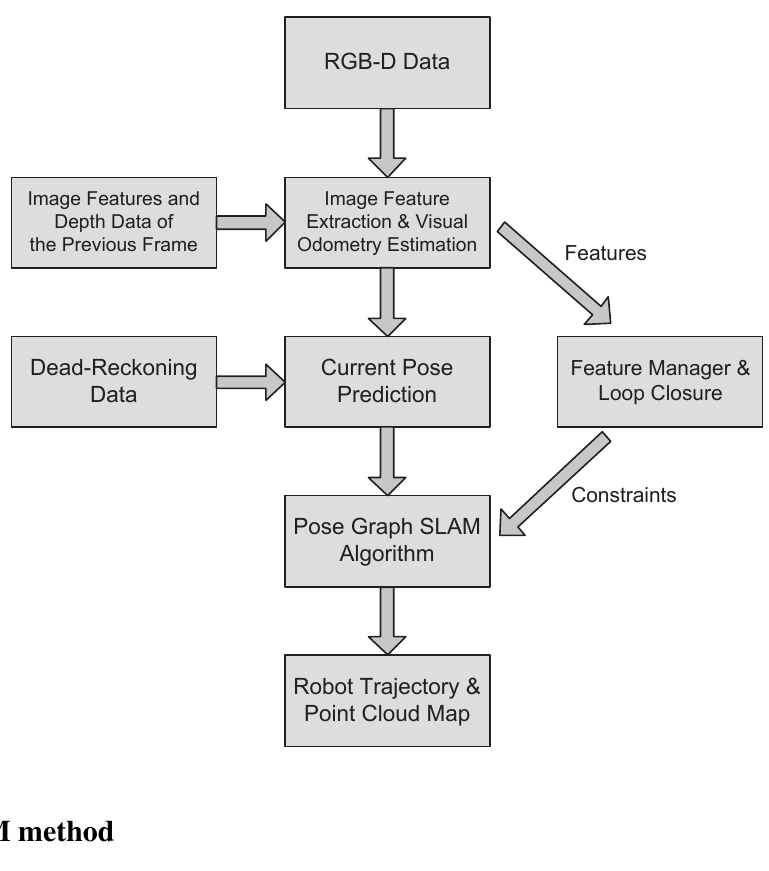
Figure 3. Processing steps required by the RGB-D SLAM